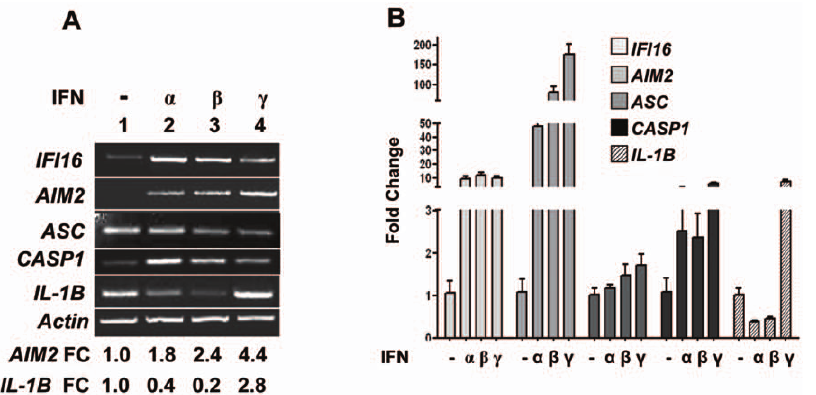
Figure 2. IFNs induce the expression of the IFI16, AIM2, and inflammasome genes. (A ) Total RNA was extracted from THP-1 cells either left untreated (control) or treated with IFN- a (Universal IFN; 1000 u/ml), IFN- b (1000 u/ml), or IFN- c (10 ng/ml) for 12 h. Relative steady-state levels of mRNA were analyzed by semi-quantitative RT-PCR using a pair of primer specific to the indicated genes. FC, indicates the fold change in the steady- state levels of the AIM2 or IL-1B mRNA as compared to the control (lane 1). ( B ) Total mRNA in panel ( A ) was also analyzed for steady-state levels of mRNAs for the indicated genes by quantitative real-time PCR. The relative steady-state levels of the mRNA in control cells for each gene are indicated as 1. Results are mean values of triplicate experiments and error bars represent standard deviation.